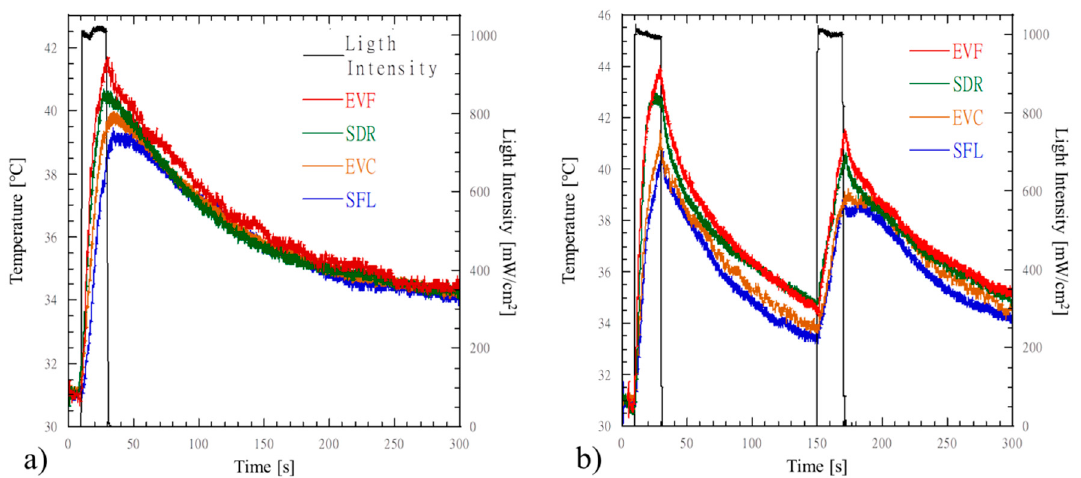
Figure 3. Simultaneous time measurements of temperature and photo-diode signals for MOD cavities restored with the investigated bulk-fill RBCs according to: ( a ) the bulk-fill technique; ( b ) the incremental technique. Table 2. Temperature rise and temperature rate measured for the investigated bulk-fill RBCs according to the different restoration techniques. Numbers in brackets represent the standard deviation. For each column, different superscript letters denote significant difference ( p < 0.05).